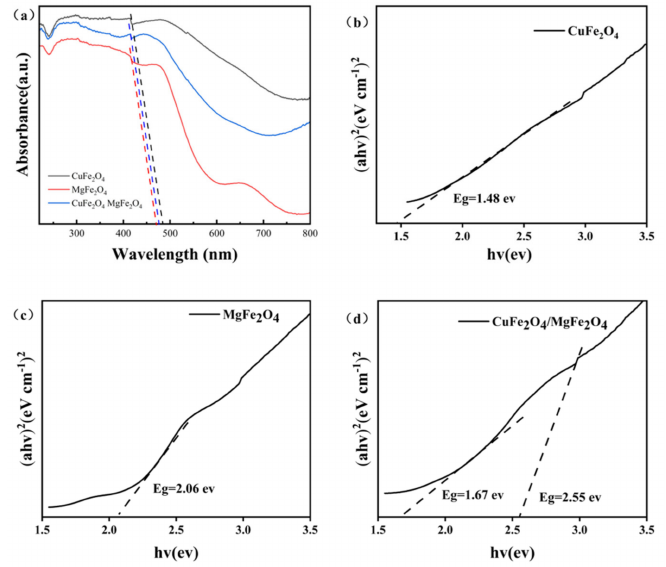
Figure 4. ( a ) UV–vis DRS of the pure CuFe 2 O 4 , MgFe 2 O 4 and CuFe 2 O 4 /MgFe 2 O 4 composites;